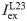
Dependence of network behavior on the magnitude of synaptic background inputs.(A) Maximum of the Kolmogorov-Smirnov test statistic (DKS) comparing the experimental and respective simulated distributions for the mean ISI, CV, and cross-correlation as a function of input currents into excitatory (Iex) and inhibitory (Iinh) neurons in layer 2/3. DKS values within the blackly delineated area have p values larger than 0.05 for each of the three tests. The insets show the three individual DKS values as a function of one of these input currents alone (for Iinh = 200 pA in the left and Iex = 400 pA in the lower inset, indicated by the white dotted lines). DKS values above 0.4 (green lines) correspond to significant (p = 0.05) deviations from experiments in the given distribution. The red asterisk indicates the parameter set used for the simulations presented in the previous figures. (B) Fraction of neurons emitting at least 10 spikes during a 30 sec simulation period for the same currents used in Panel A. The blackly delineated area was copied from Panel A and superimposed on the current graph. (C) Ratio of the number of spiking pyramidal cells between layers 5 and 2/3 as a function of the input current ratio into pyramidal cells in layers 2/3 and 5. Each data point represents the mean ± SEM over three different ratios of input currents into interneurons in layers 2/3 and 5 and a number of IexL23 and IinhL23 values.